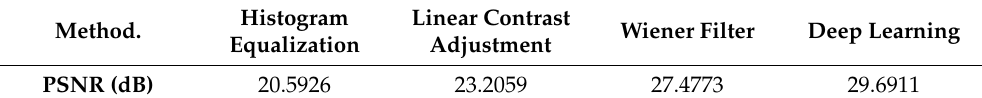
Table 3. Quantitative comparison with other traditional image-processing methods.